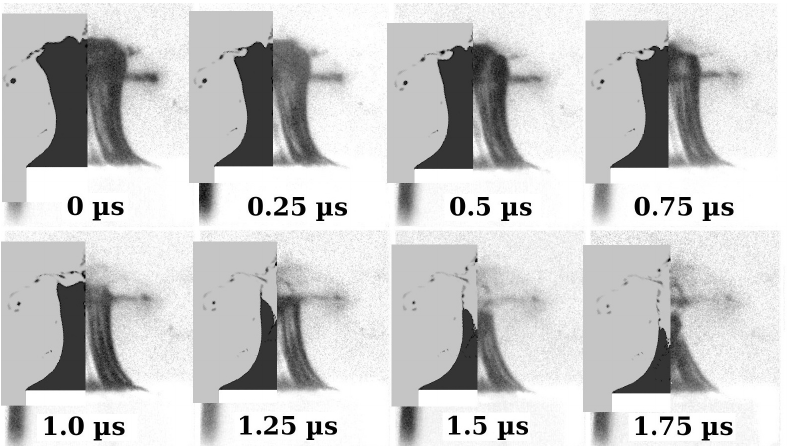
Figure 9. Imacon camera frame sequence of a mushroom bubble at a time during ring jet impact at the top of the mushroom cap. Times denote the delay to the camera trigger. Overlay with the volume fraction field α l from the axisymmetric, numerical simulation of a bubble at D ∗ = 0.057 and r ∗ p = 0.306 (mind that the numerical simulation is represented by a cut through the bubble). Background of the experimental images was subtracted. Frame width is 766µm ± 10µm. The cylinder radius r p in the experiment is 272.8µm, in the simulation r p is